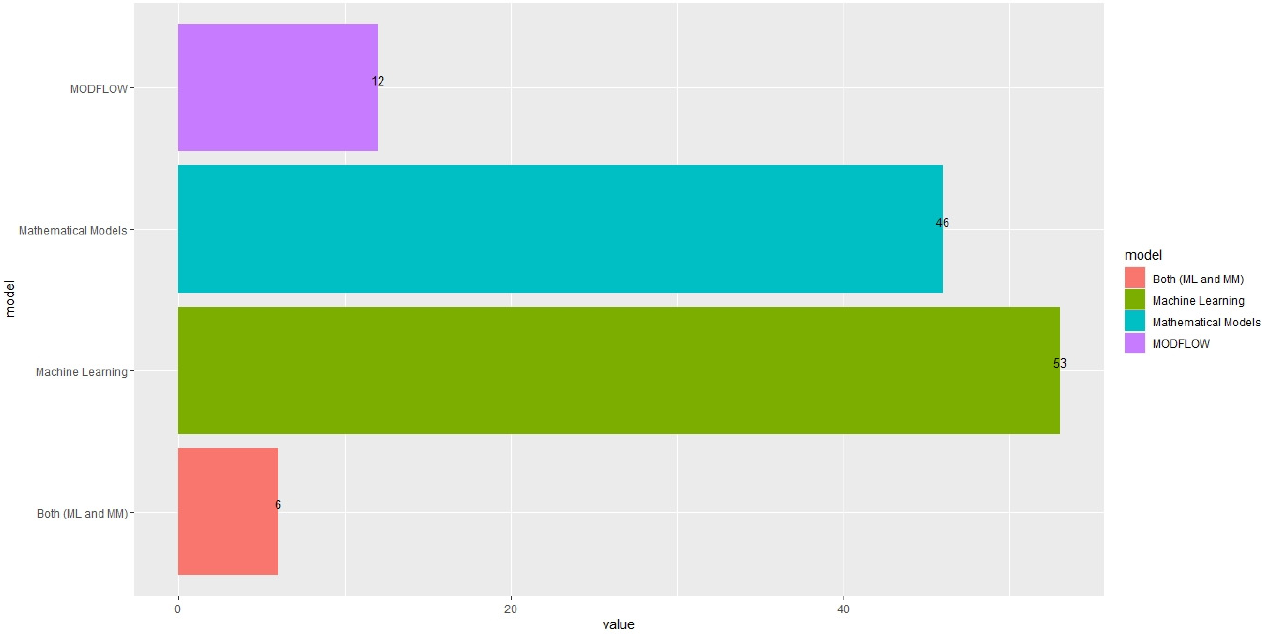
Figure 8. Techniques for modeling groundwater flows. Table 5. ML techniques for predicting GWL